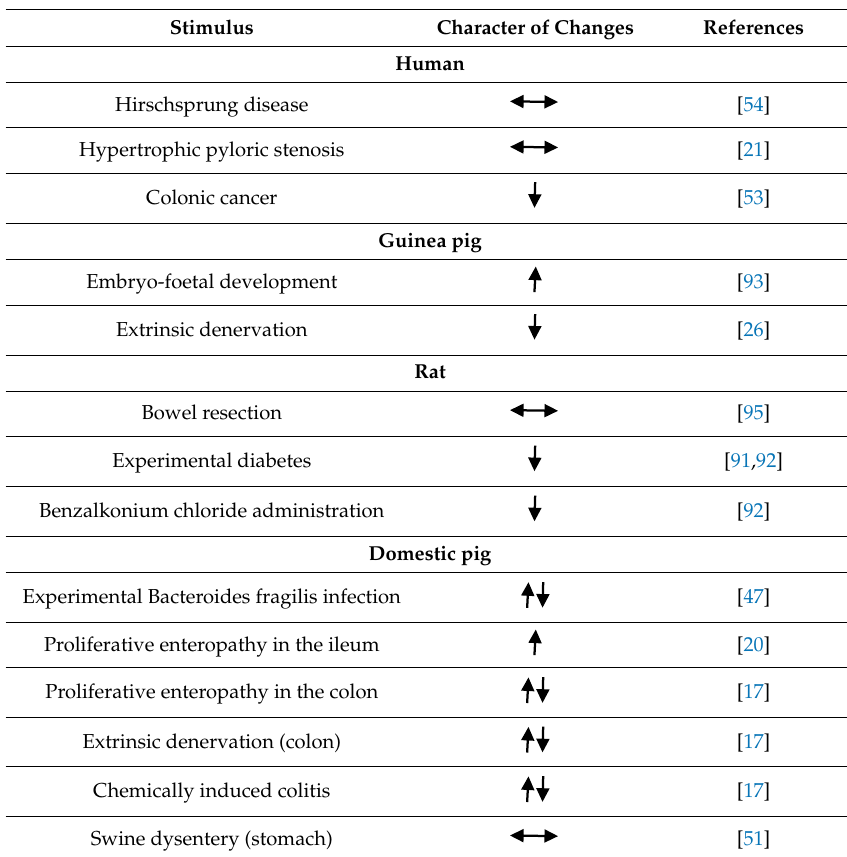
Table 2. The changes in the number of somatostatin-positive (SOM+) nervous structures in the wall of the digestive tract under physiological and pathological stimuli: an increase in the number of SOM+ nervous structures, a decrease in the number of SOM+ nervous structures, various changes depending on the part of the enteric nervous system, changes were not observed.